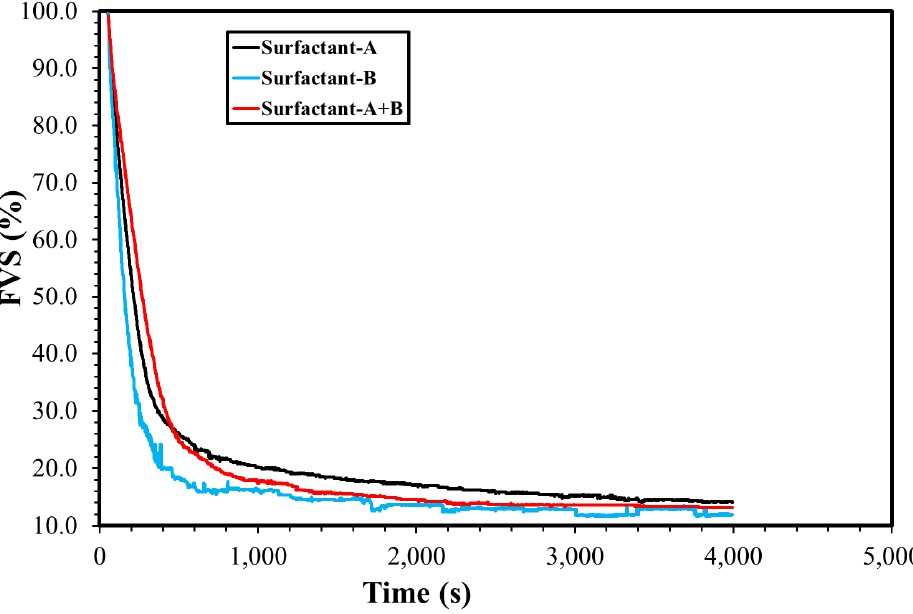
Figure 6. FVS of different surfactant systems in deionized water using CO 2 injection at 25 °C.